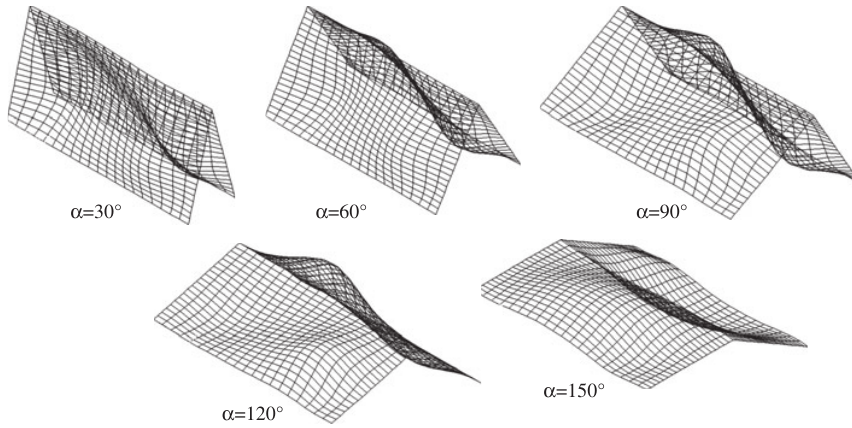
Figure 4 Thermal buckling modes for different crank angles of one-fold laminated plates.